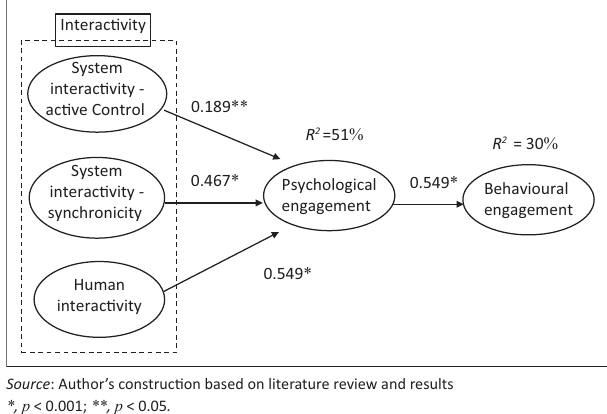
FIGURE 2: Results of the analysis of the structural TABLE 3: Effects of interactivity on engagement. Predicted variable